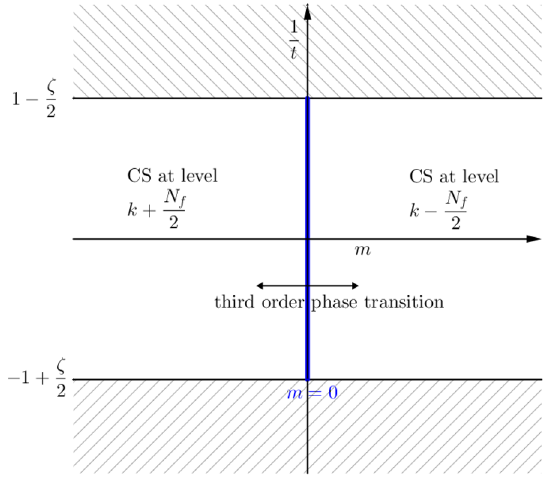
Figure 14 . Phase diagram of the SU( N ) theory with N f hypermultiplets all of mass m at λ → ±∞ . Across the blue wall m = 0 the theory undergoes a third order phase cr